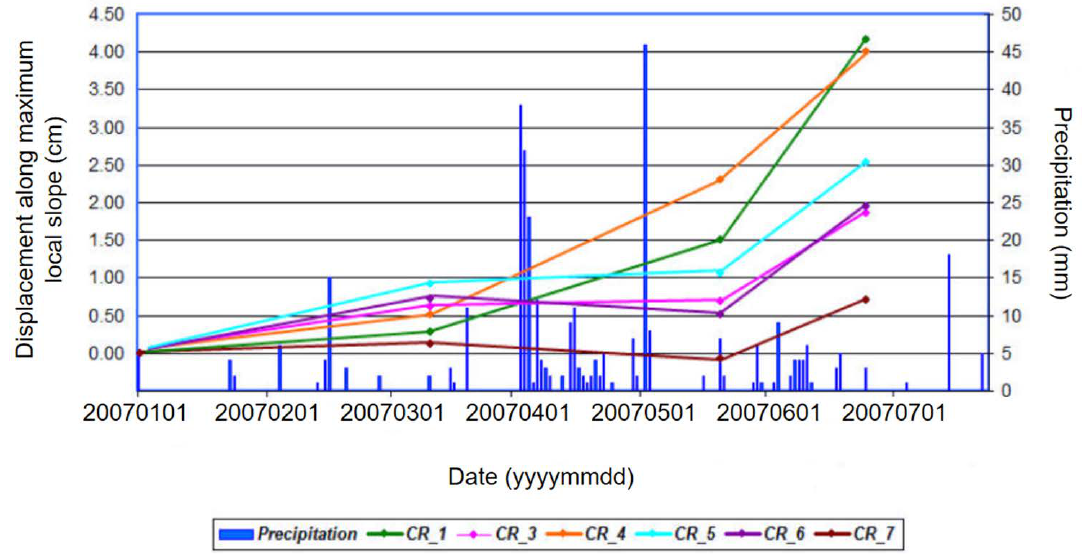
Figure 17. Evolution of the displacements (cm) of the CRs during the first half of 2007. The relative Line-Of-Sight (L.O.S.) displacement was corrected to the direction of the maximum local slope. Precipitation (mm) is also presented as vertical